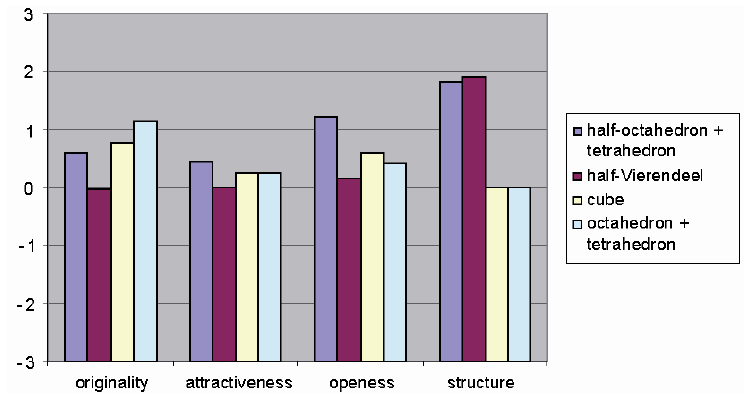
Figure 12: The average evaluation of the factors originality, attractiveness, openness and structure for the space structures half-octahedron + tetrahedron, half-Vierendeel, cube and octahedron +